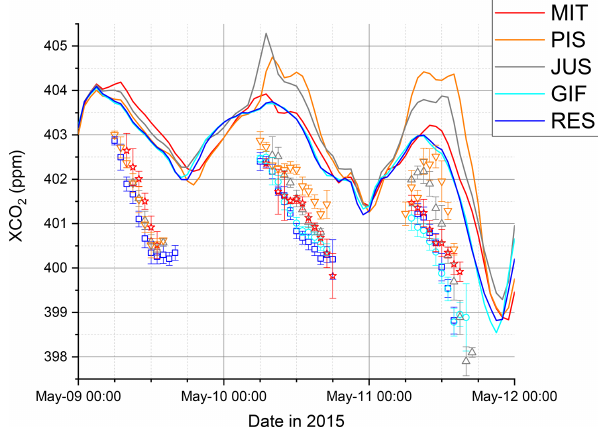
Figure 8. Comparison of modelled (solid lines) and observed hourly averaged XCO 2 (symbols) with standard deviations as error bars.